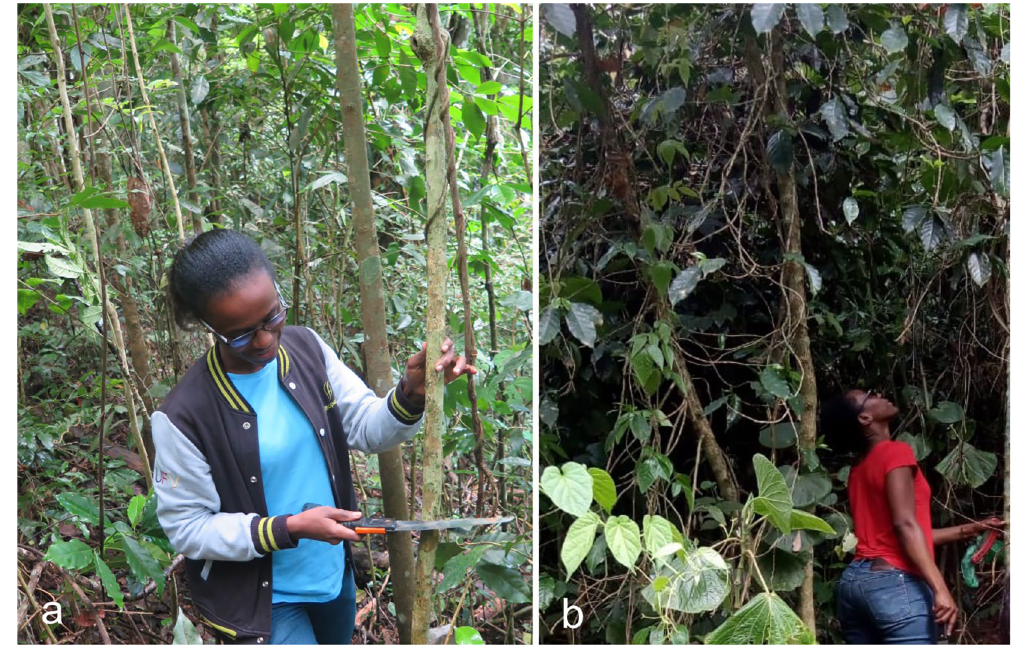
Figure 16. Survey sites in semi-wild situations in Brazil. ( a ) Miraine Ndacnou collecting a sample of mature Coffea arabica from the forest reserve Mata do Paraíso (Universidade Federal de Viçosa, state of Minas Gerais, Brazil). Notice the well-established secondary forest (Mata Atlântica) under which the coffee plants exist. ( b ) Miraine Ndacnou selecting a mature Coffea arabica growing in a forest fragment (Mata Atlântica) of